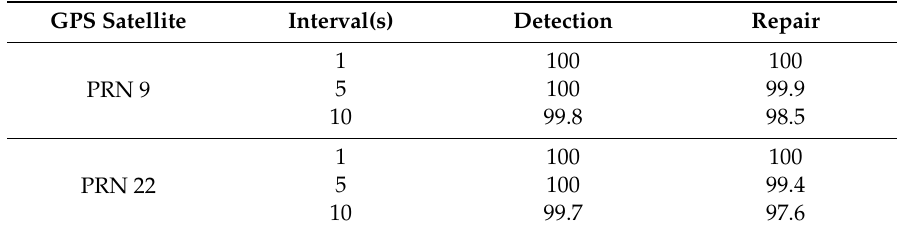
Table 5. Correct instances of detection and repair of cycle slips (in percentage) using STG methods for the GOCE GPS dataset above with sampling rates of 1-s, 5-s, and 10-s intervals for PRN 9 and PRN 22. GPS Satellite